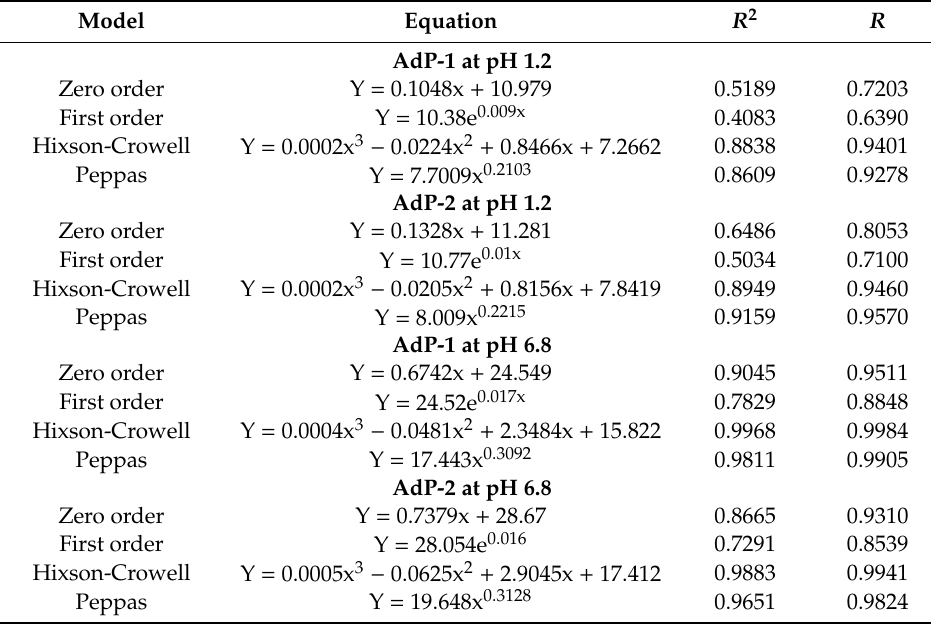
Table 3. In vitro release kinetics equation simulation of the nano-carriers.